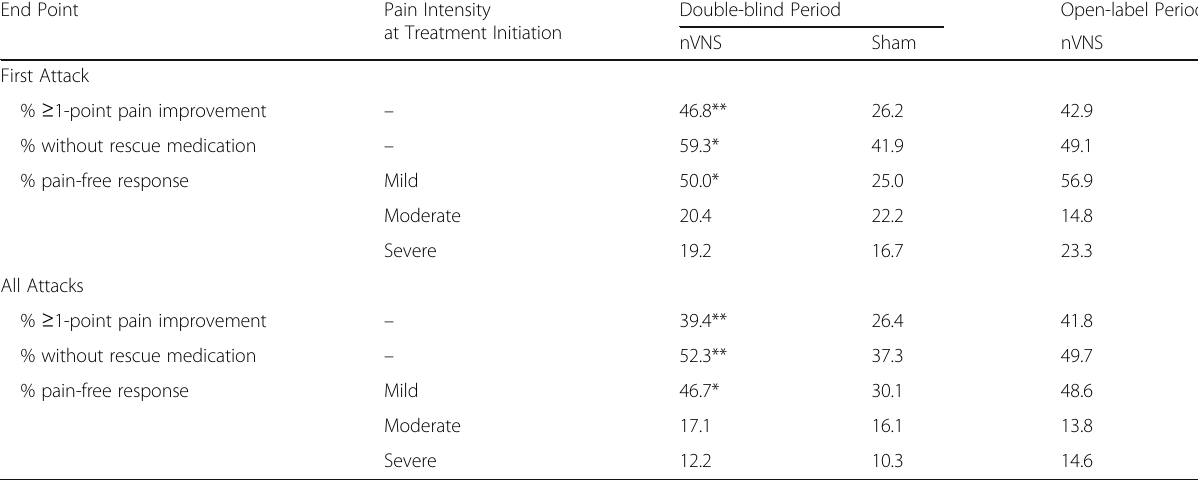
Table 1 Summary of Clinical Utility Outcomes at 120 Minutes After Treatment Initiation (Double-blind and Open-label Periods) End